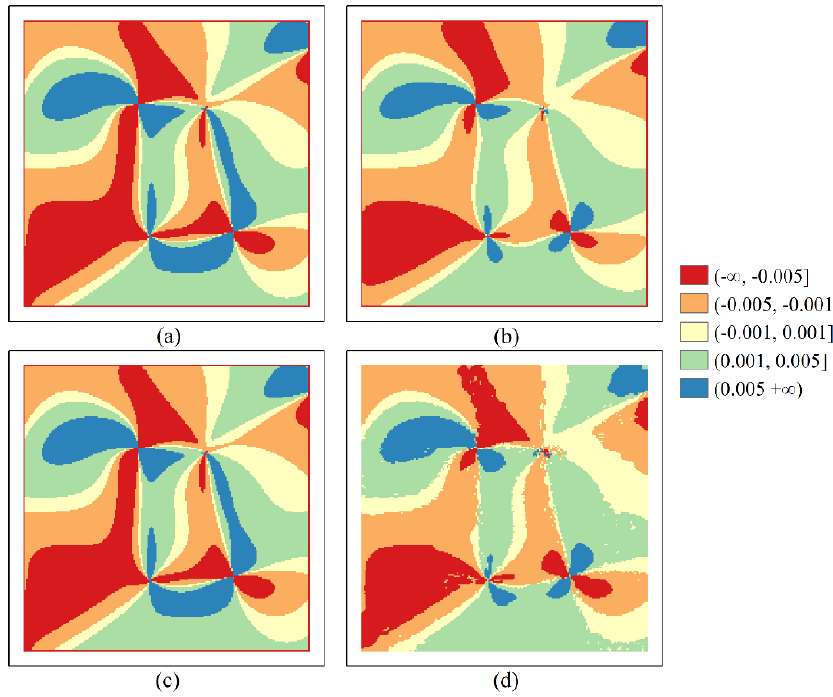
Figure 11. Spatial distribution of the residuals of the simulated C values relative to the theoretical C values on G2 for the: ( a ) Evans, ( b ) Zevenbergen, ( c) Shary, and ( d ) FPN-based methods.